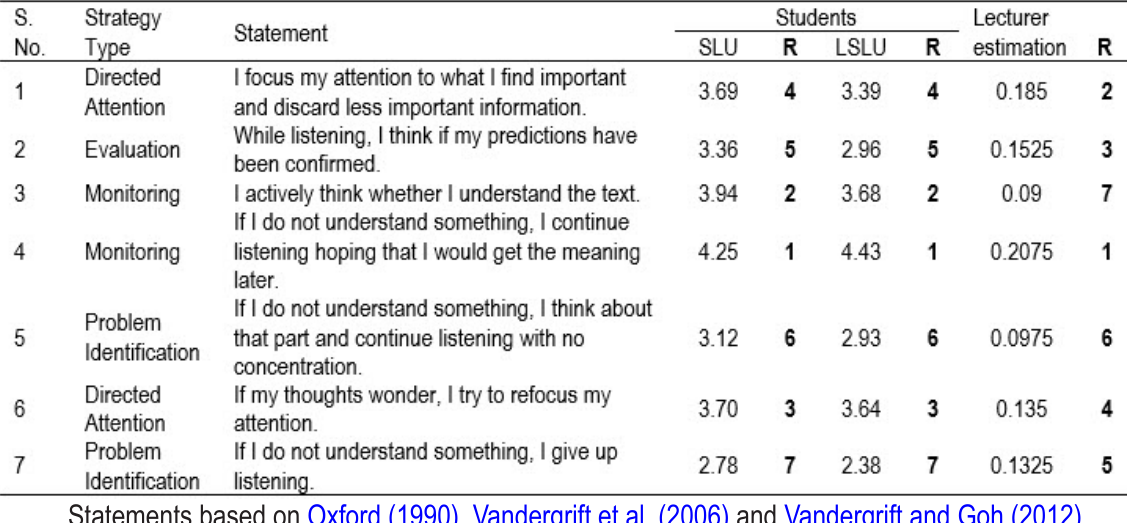
Metacognitive strategies - students’ preferences, lecturers’ estimation of the strategy utility and the strategy rank